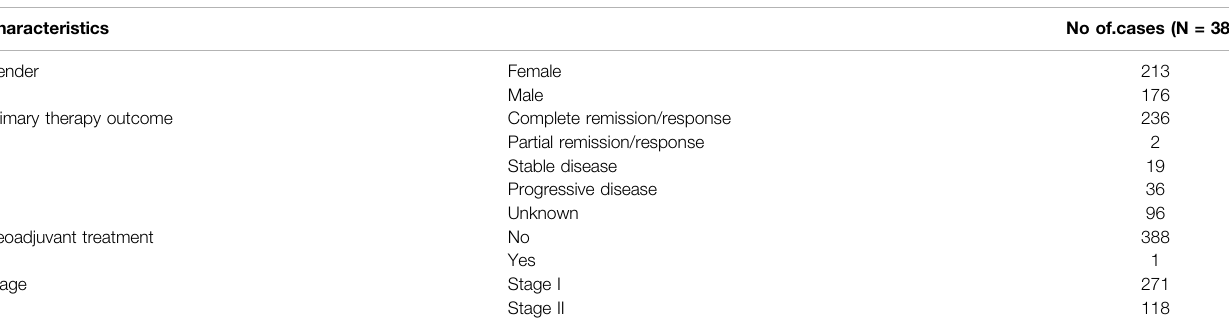
TABLE 1 | Clinical information of early-stage LUAD patients in TCGA cohort.